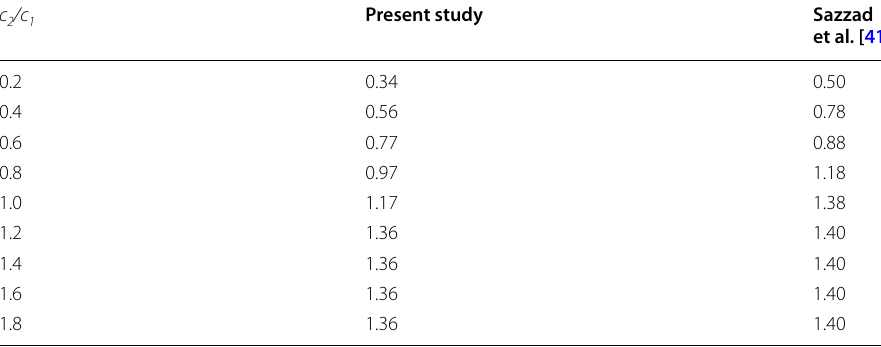
Table 9 A comparison of F obtained by Sazzad et al. [41] with the present solutions considering s φ φ 0° and β 1 = 2 = =